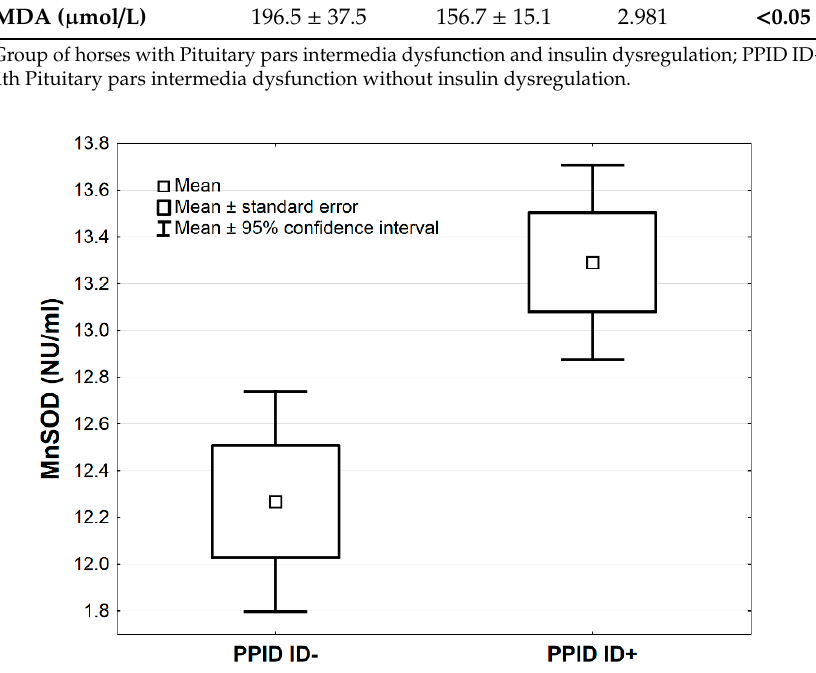
Figure 3. Mean values of MnSOD activity measured in serum of horses in PPID ID + and PPID ID − groups. Statistical significance was set at p < 0.01.